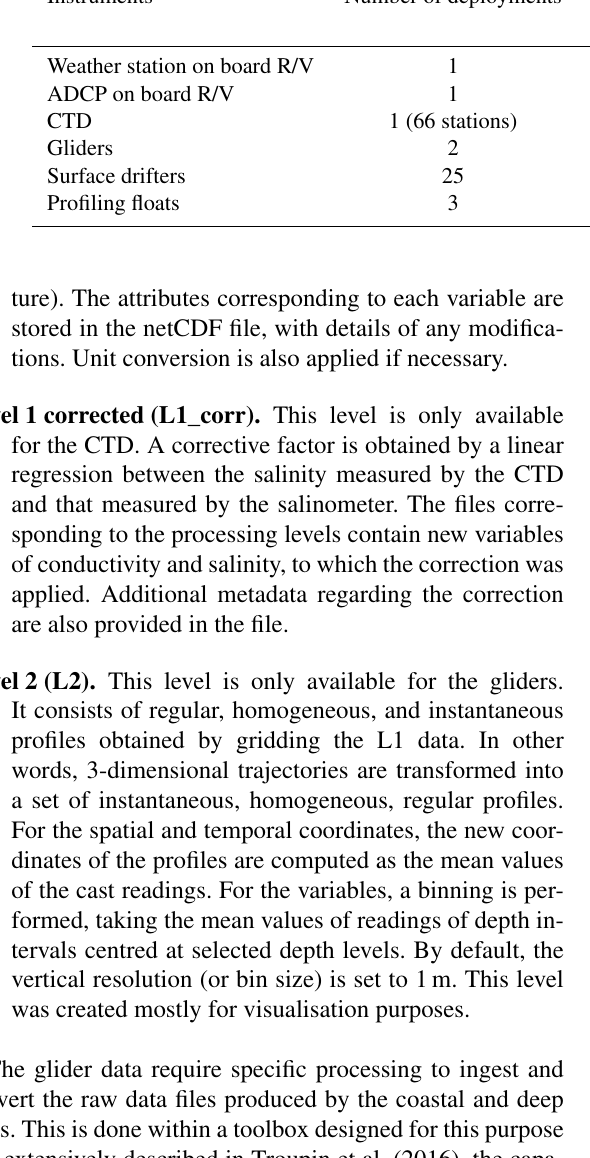
Table 1. Characteristics of the instrument deployments in AlborEx. Instruments